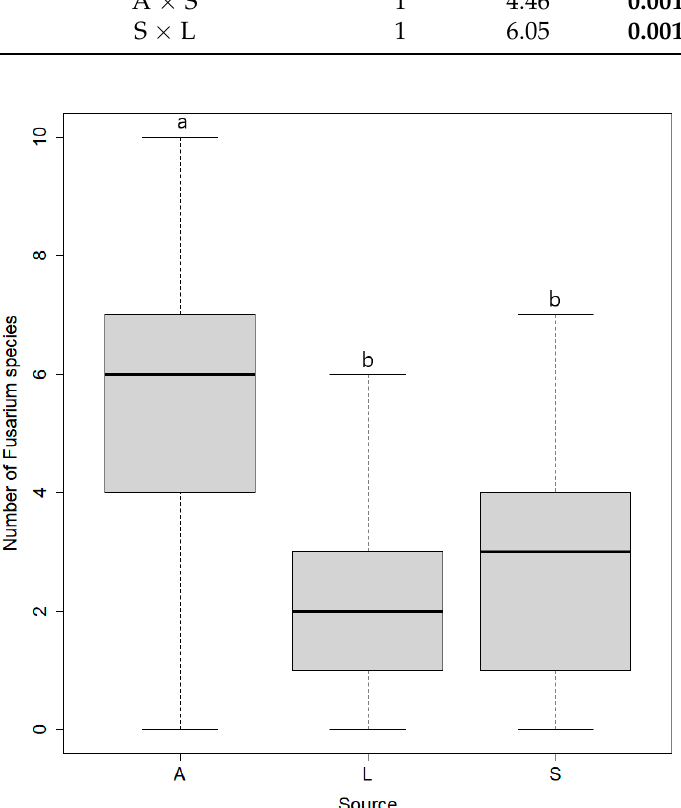
Figure 4. Number of identified Fusarium species on the body surface of arthropods (A), in samples of litter (L) and soil (S). The midline of all boxplots represents the median, with the upper and lower limits of the box being the third and first quartile, respectively. Whiskers will extend up to 1.5 times the interquartile range from the top/bottom of the box. Different letters above the boxplots indicate significant differences.